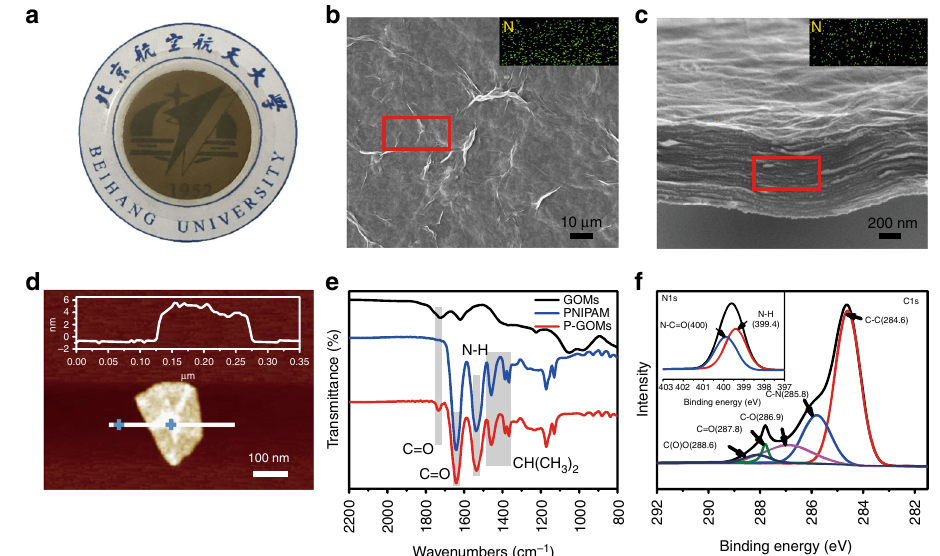
Fig. 2 Characterization of P-GOMs. a Digital photo of P-GOMs. b , c Top-view and cross-sectional SEM images of P-GOMs showing a typical wrinkle surface and stacking microstructure. The insets are EDS maps indicating that nitrogen is evenly distributed on both surface and cross-section of P-GOMs. d AFM image of a single P-GO sheet with thickness ~5 nm. e ATR-FTIR spectra of GOMs, PNIPAM and P-GOMs, illustrating covalent bound between PNIPAM and GO. f XPS spectrum of P-GO, of which C1s region fi tting into fi ve peaks at 284.6, 285.8, 286.9, 287.8, and 288.6 eV, representing C – C, C – N, C – O, C = O and C(O)O. Inset is N1s region, fi tting into two peaks at 399.4 and 400.0 eV, representing amine and amide, respectively, because of the graft of